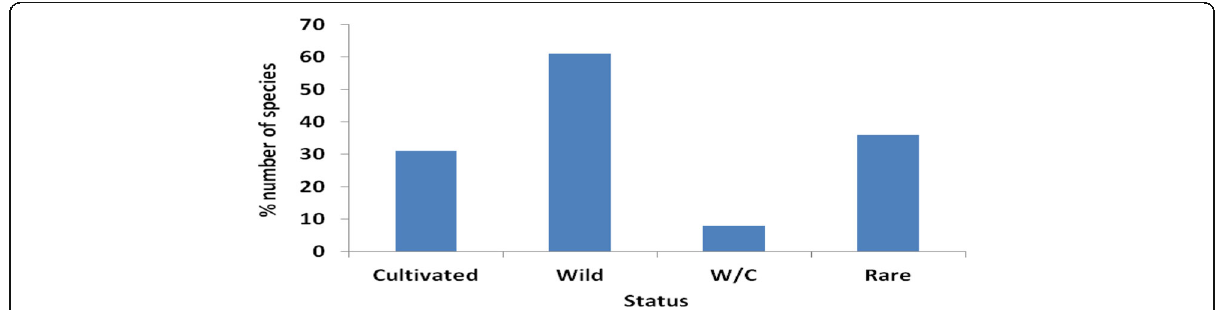
Fig. 2 Conservation of the medicinal plant